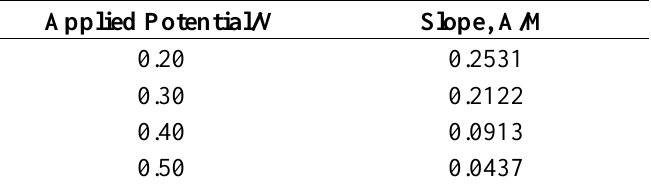
Table 2. Slope variation with applied potential, from different calibration curves for W(VI).